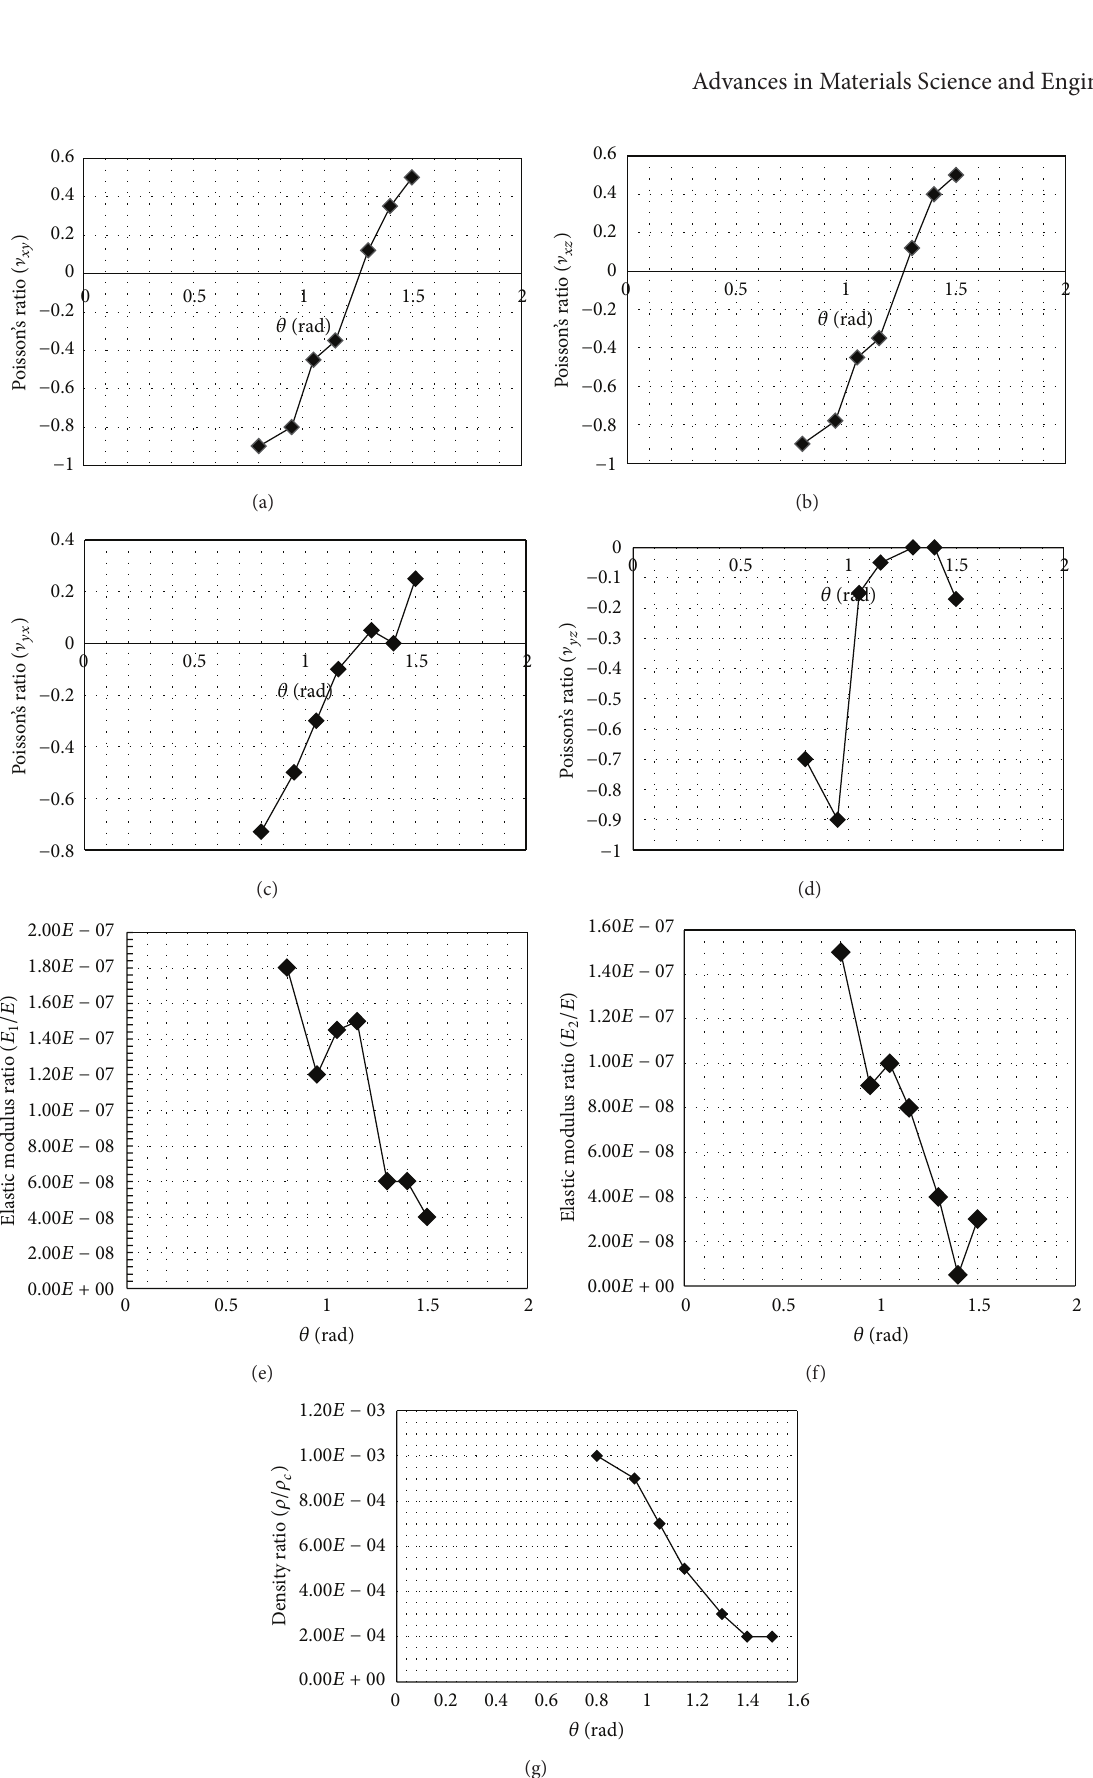
Figure 4: Mechanical properties versus 𝜃 in the case of fixing 𝛽 and 𝛾 at 0.8 and 0.02,